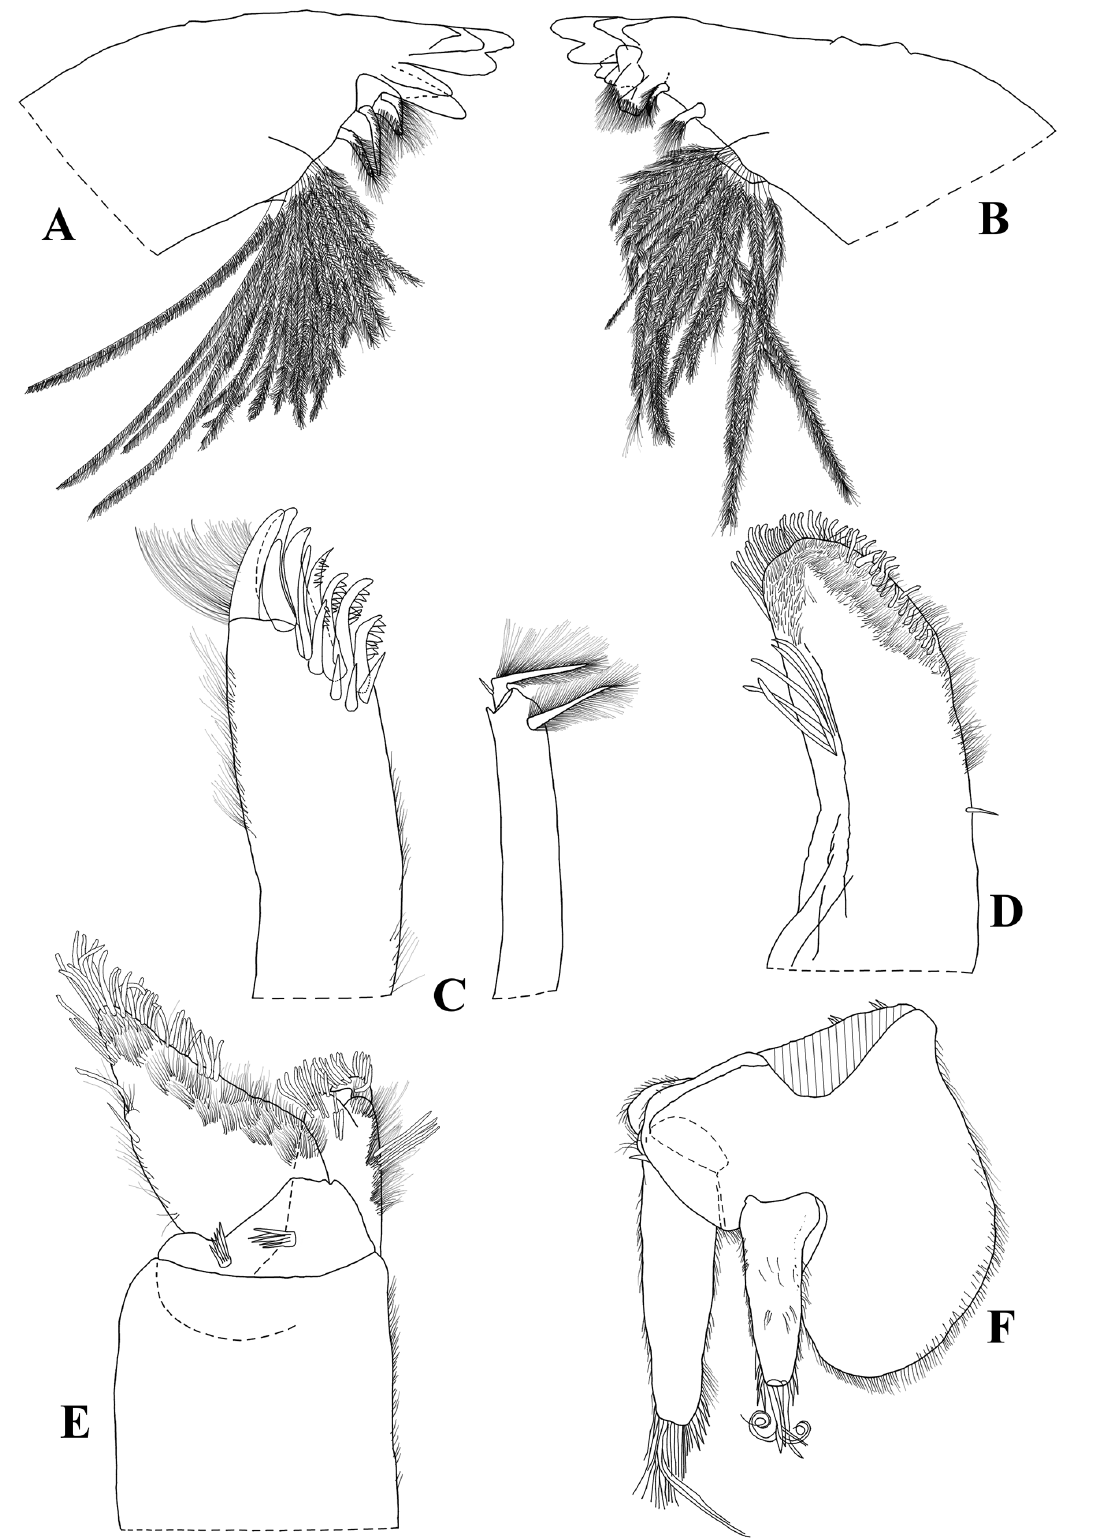
Fig. 11. Armadilloniscus luisi Carpio-Díaz, Taiti & Campos-Filho sp. nov., paratype, ♀ (CDUC- CRU 194). A . Left mandible. B . Right mandible. C . Maxillula. D . Maxilla. E . Maxilliped. F .